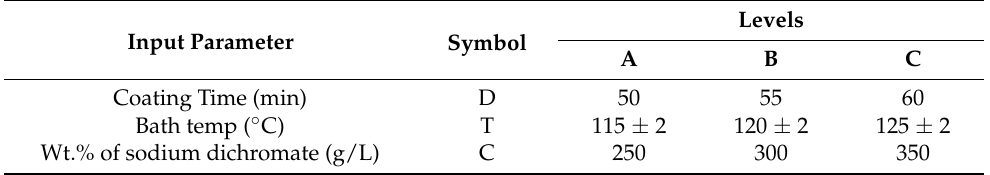
Table 2. Table 1. Selected parameters and experimental levels.